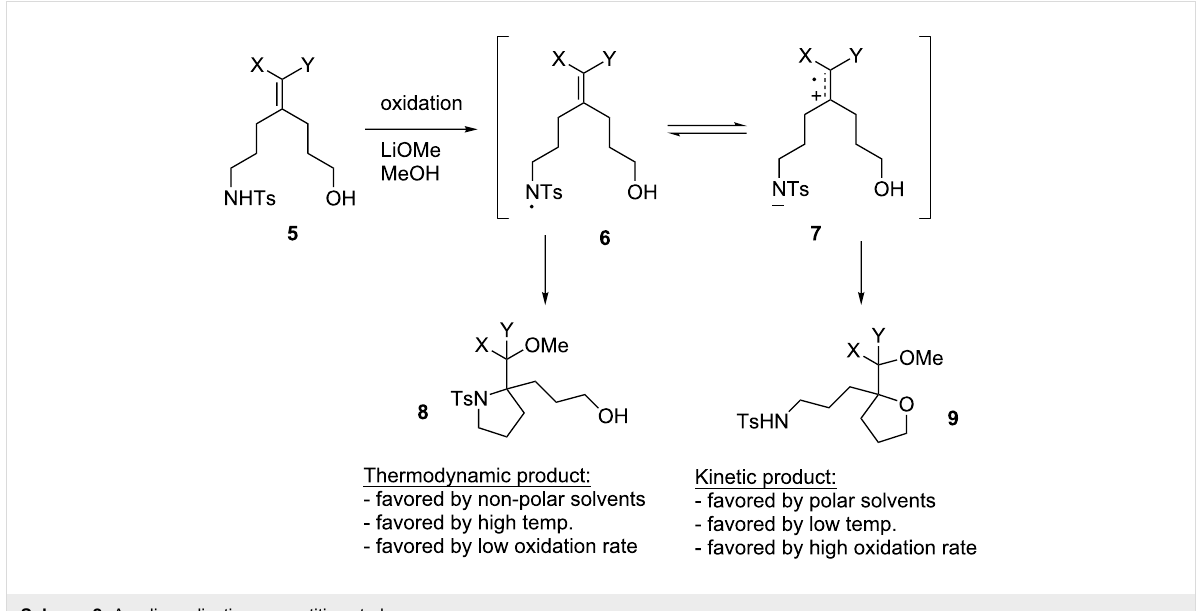
Scheme 2: Anodic cyclization competition study.